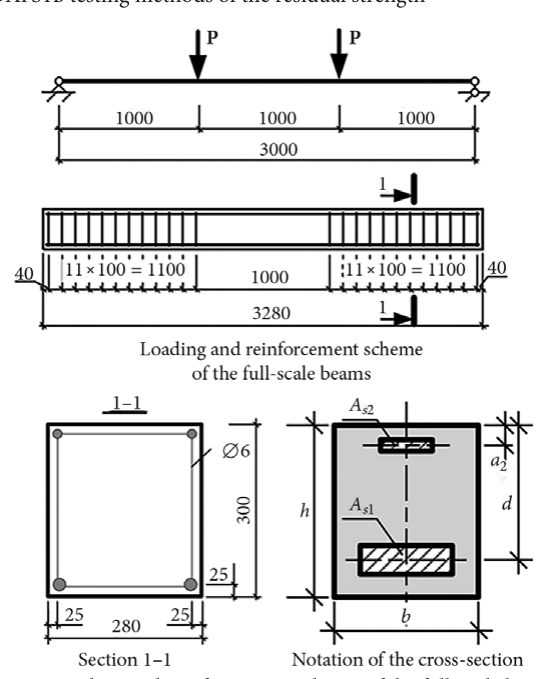
Fig. 2. Loading and reinforcement scheme of the full-scale beams and notation of the cross-section (Table 2 for the Reference) Table 1. Composition of the concrete mixtures in kg/m 3